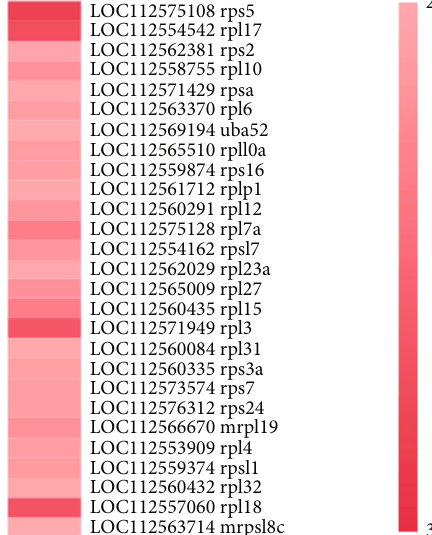
Figure 3: Expression pro fi le of di ff erentially expressed genes annotated with ribosomal signaling pathways. The bar ’ s color represents the fold of upregulation of the corresponding gene. The darker the color, the larger the value, indicating that the fold of the gene is upregulated.